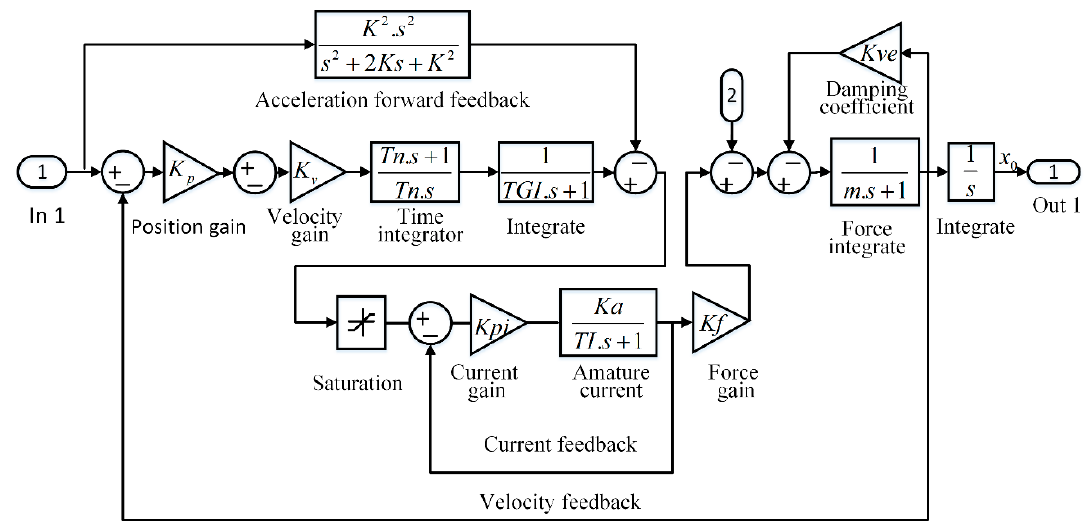
Figure 20. Block diagram of P-PI controller with acceleration feed-forward of the linear feed drive with magneto-rheological fluid (MRF) damper. Reprinted with permission from ref. [106]. Copyright 2010 IEEE.